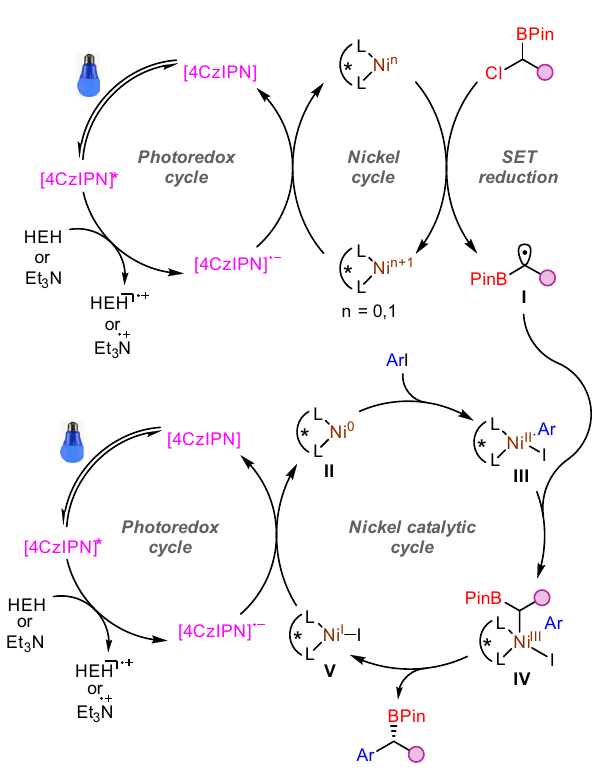
Fig. 7 Proposed mechanism. A proposed catalytic cycle for the dual catalytic coupling.